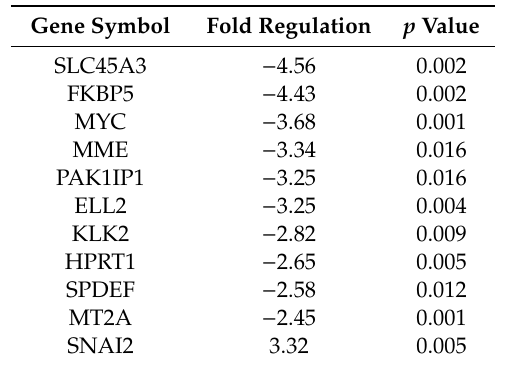
Figure 1. CYP3A5 siRNA downregulates AR (androgen receptor) nuclear translocation: ( A – C ) MDAPCa2b cells were transfected with CYP3A5 and non target (NT) siRNA. After 72 hours, the cells were given 10nM DHT treatment (0, 1, and 2 hours). ( A ) Western blot was performed to test CYP3A5 siRNA silencing efficiency at protein level using cytoskeletal fraction. Total protein was used to monitor changes in total AR protein expression. ( B ) For microscopy, the cells were labelled with AR primary antibody and Cy5 secondary (red) and nucleus was labeled with DAPI. The scale bar represents 50 µ m. ( C ) After cell fractionation, western blotting was performed using cytoplasmic and nuclear fractions and probed for AR, Tubulin, and Lamin. Table 2. CYP3A5 inhibition downregulates AR (androgen receptor) downstream regulated genes. Gene Symbol Fold Regulation